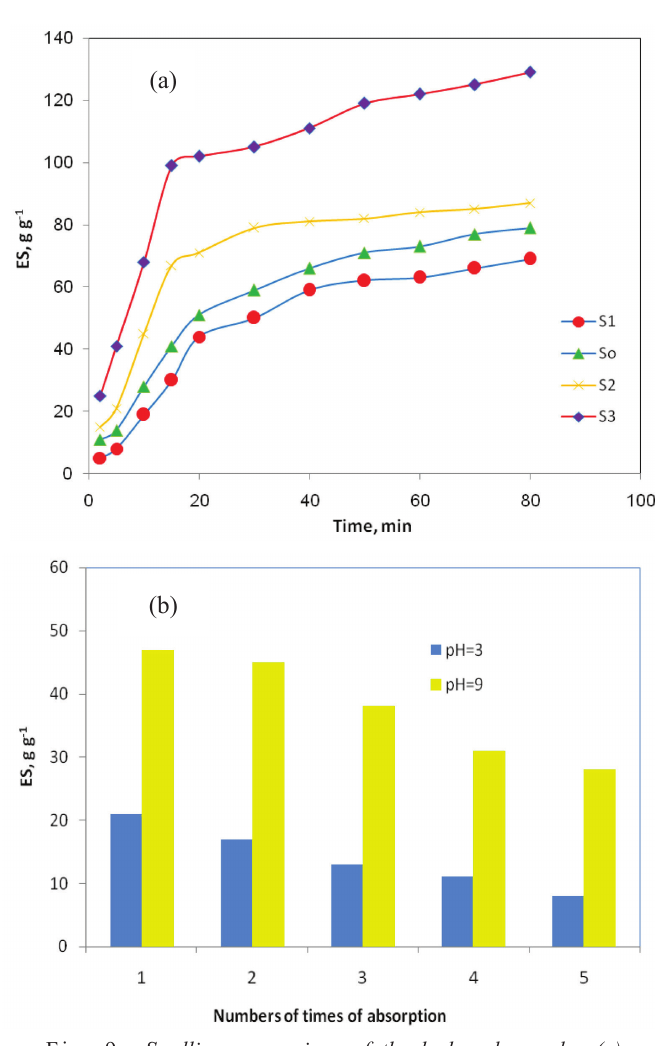
Fig. 9 – Swelling comparison of the hydrogel samples (a) and reversibility behavior of the MHN adsorbent in pH 3.0 and 9.0 at 37